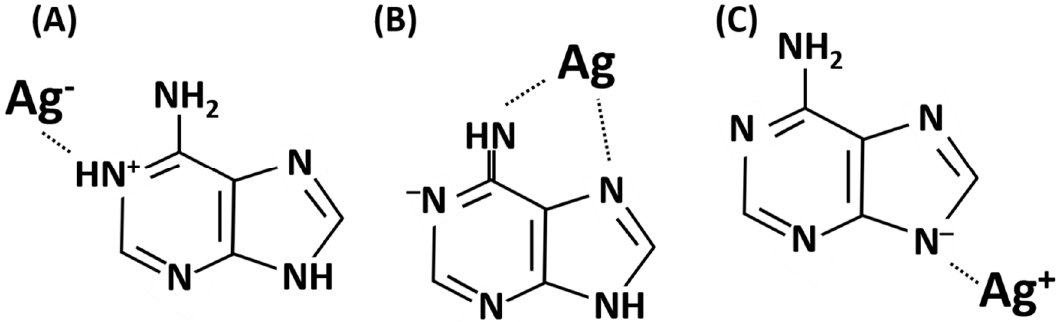
Figure 3. Schematic diagrams of adenine adsorption on silver. ( A , C ) Electrostatic interactions of adenine with silver and ( B ) interactions by functional groups of adenine molecules with silver.